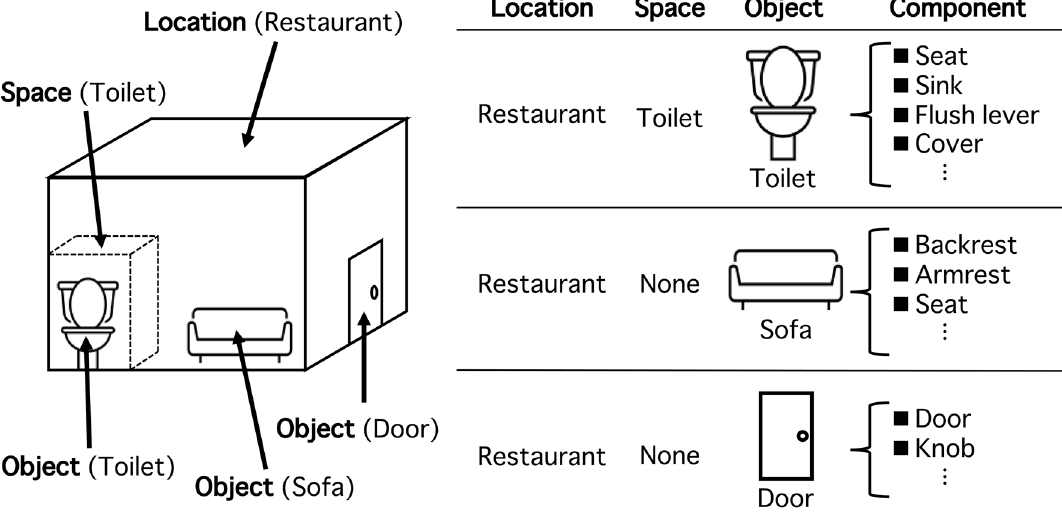
Figure 1. Scheme for organizing objects in this study. “Location” was a major category that contains several “spaces.” The figure on the left shows an example of a restaurant, which is one of the 12 major locations investigated in this study. The restaurant contains three objects, sofa, door, and toilet. In the example, toilet is a space (space: toilet) that contains the object toilet (location: restaurant; space: toilet; object: toilet). The figure on the right is an example of the structure of the objects included in the space and their components. As “space” was often omitted, such entries sometimes did not exist (expressed as